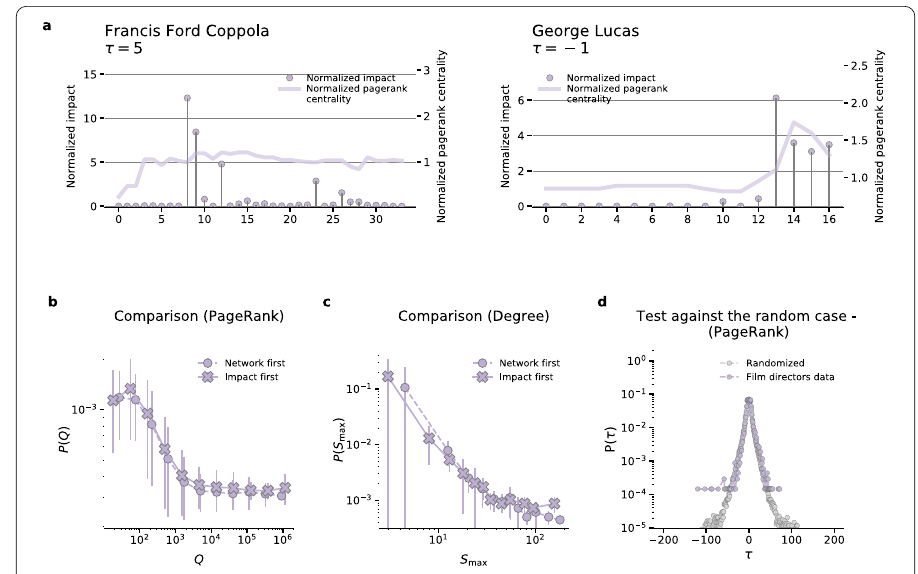
Figure 3 Network position and timing of biggest hit for movie directors. ( a ) We report the impact S of Francis Ford Coppola illustrating the case when PageRank centrality peaks first ( τ = 5), followed by the impact, while the example of George Lucas illustrates the opposite behavior ( τ = +1), where a peak in the impact is followed by the peak in networking. The figure then shows a comparison between the groups of film directors for whom success peaks before (colored continuous lines) and after (colored dashed lines) their network peak. For movie directors, ( b ) their network position based on their PageRank and their success measured by their Q parameters, ( c ) their network position based on their degree and their success measured as their highest impact, the binned (15 bins) distributions of the two groups do not show any significant difference based on the Kolmogorov–Smirnov test ( d degree = 0.02, d PageRank = 0.02, p < 0.0001). ( d ) Shows the distribution of the shift parameter τ between the directors’ network centrality (PageRank) and impact time series, coloring the distribution corresponding to the original data by orange, and to the randomized data by orange (KS test d = 0.27, p <